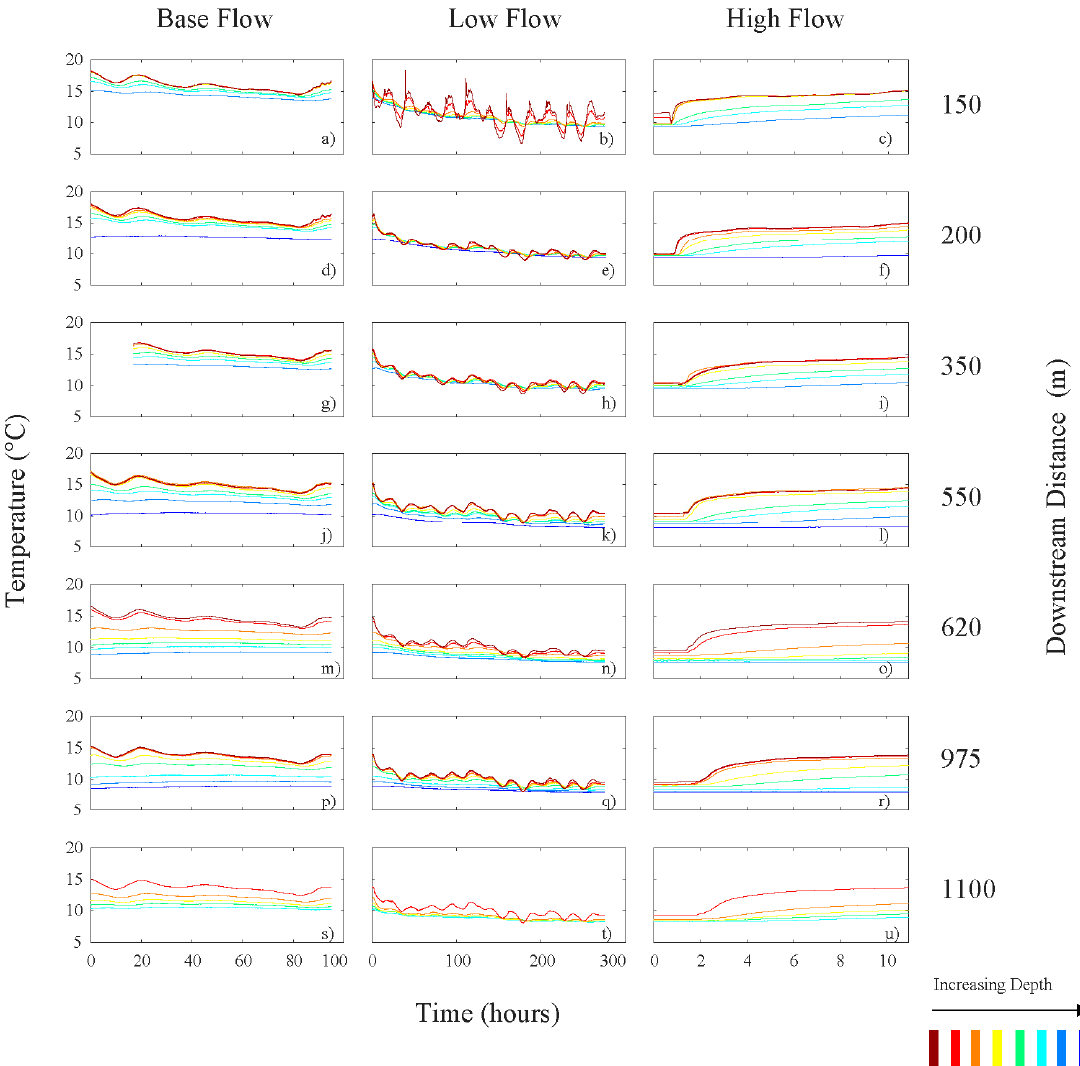
Figure 3. Water temperature time series measured at different locations along the stream network for different flow discharges. Each color represents the temperature recorded by sensors at increasing depth. Colors range from brown to blue as depth increases. Temperatures were not properly recorded during the first 20 h by the temperature stick located 350 m from the upstream station (panel g), and these were therefore neglected. High-flow discharge corresponds to high flow 1 period of Table 2.